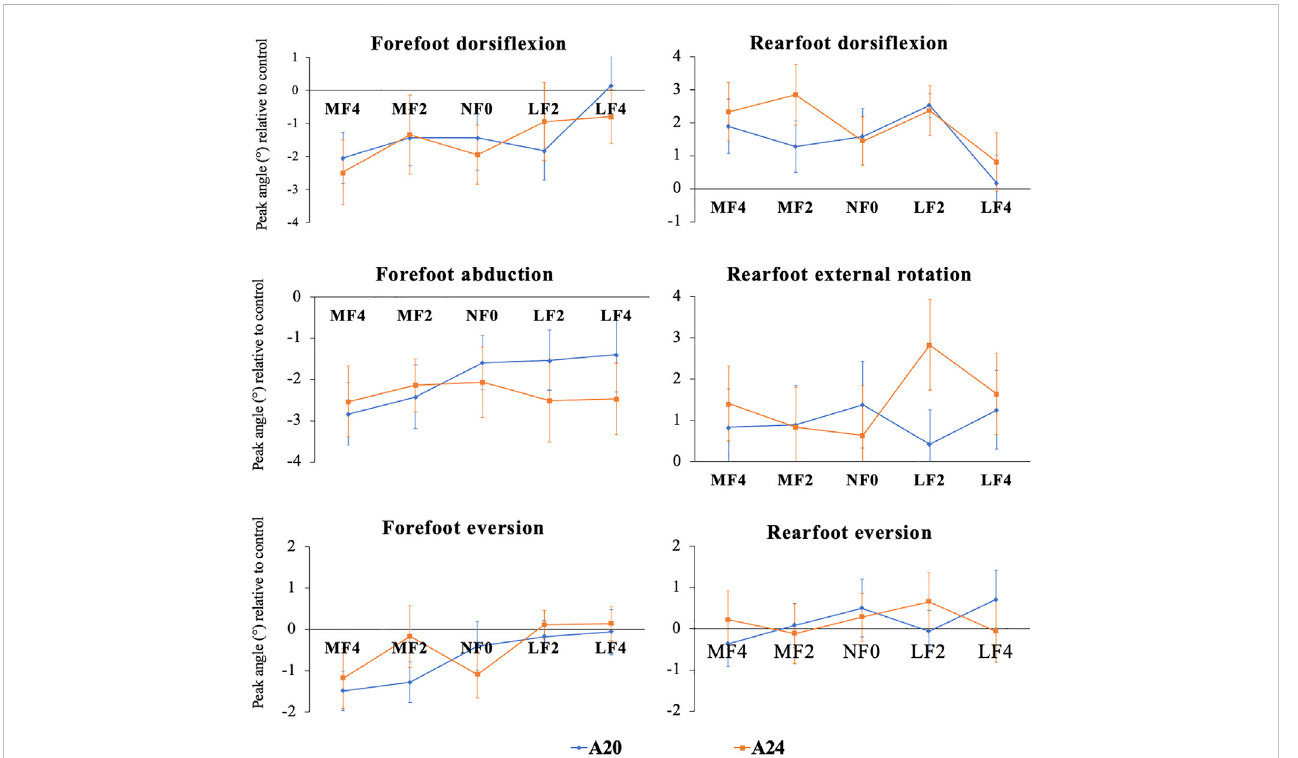
FIGURE 3 Average peak joint angles (± standard error) during the stance phase of jogging. A20 and A24: Arch support height of 20 mm and 24 mm, respectively; MF4,MF2,NF0,LF2andLF4:forefootcomponentwith4 mmmedialwedge,2 mmmedialwedge,nonewedge,2 mmlateralwedgeand4 mmlateralwedge, respectively. Blue line represents FOs with A20 and orange line represents FOs with A24.